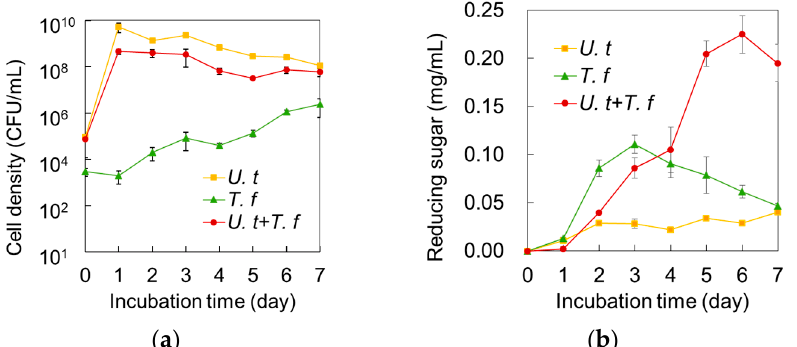
Figure 1. Cell densities ( a ) and reducing sugar production ( b ) in the cultures of T. fusca , U. thermosphaericus and both